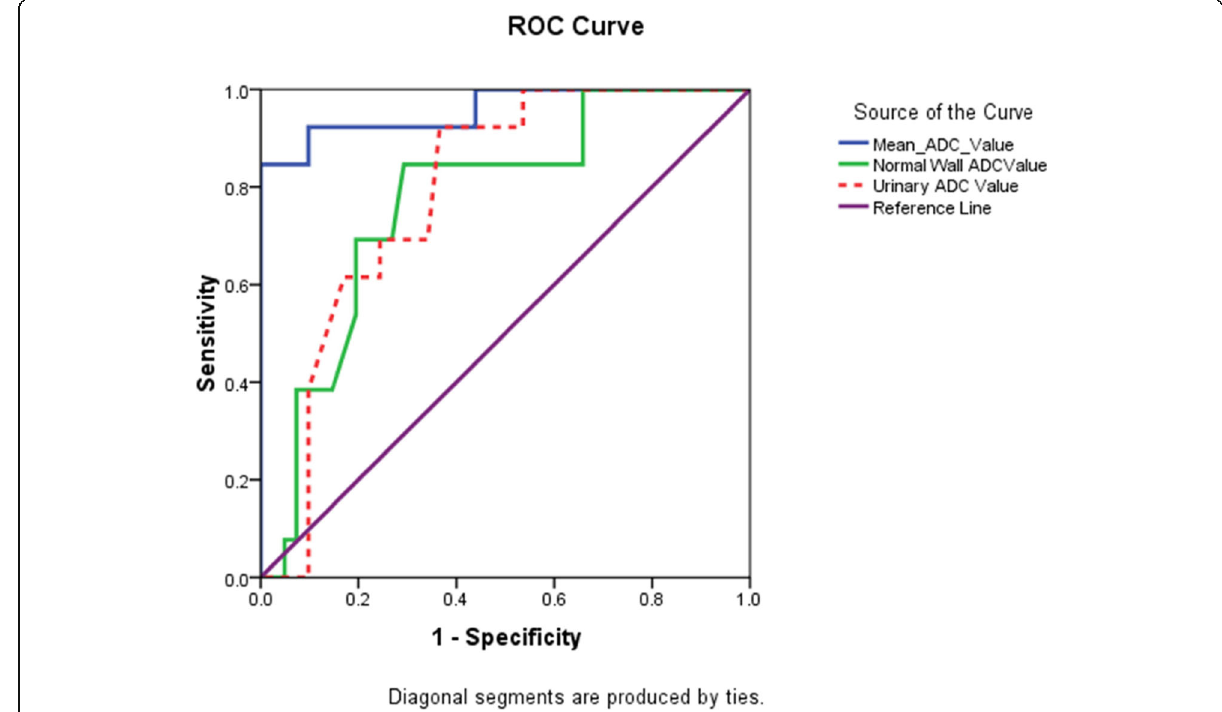
Fig. 3 ROC based on ADC values